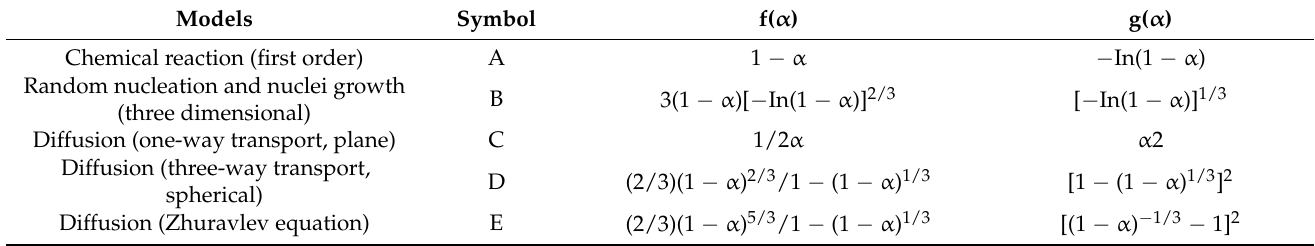
Table 2. Pyrolysis models with different reaction mechanisms for